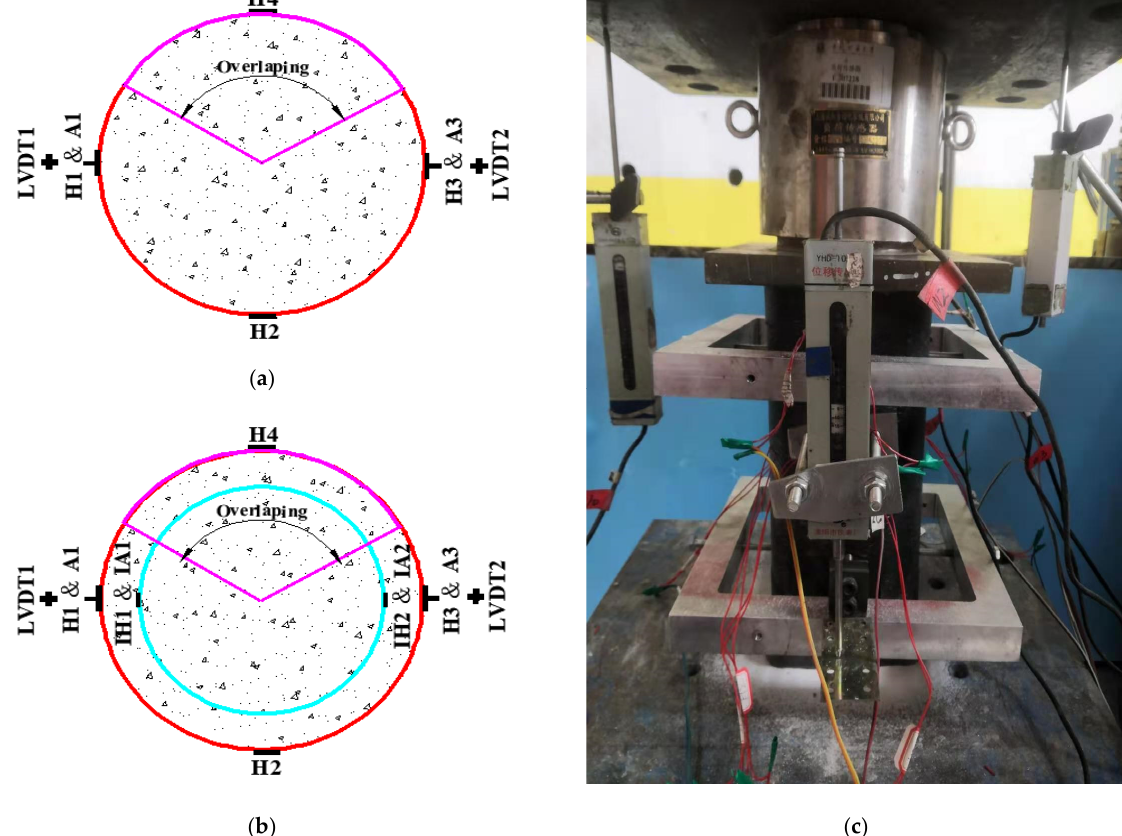
Figure 6. Test setup and instrumentation. ( a ) Instrumentation of CFFT; ( b ) instrumentation of DTCC; ( c ) test setup.